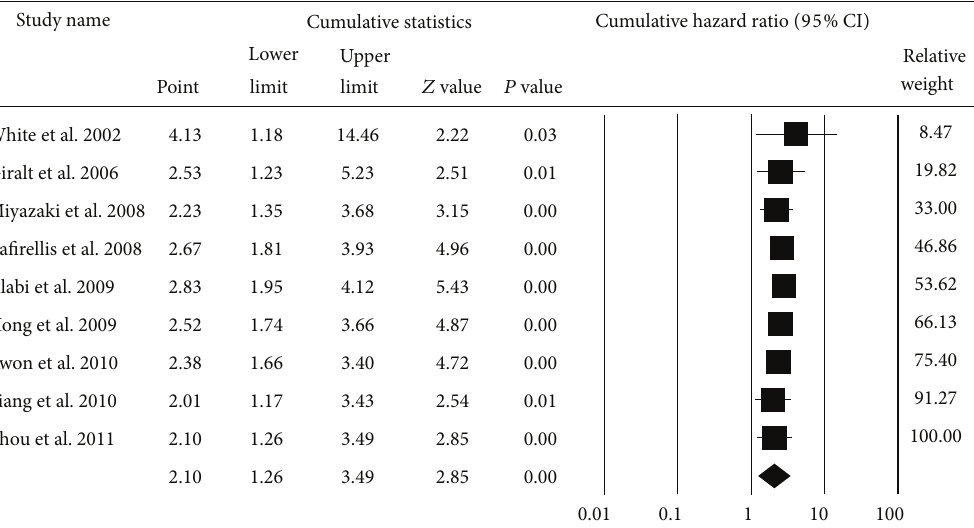
with vascular metastasis compared to those without (pooled OR = 1.43 , 95% CI: 1.06–1.92; 𝑃 = 0.02 ; mean